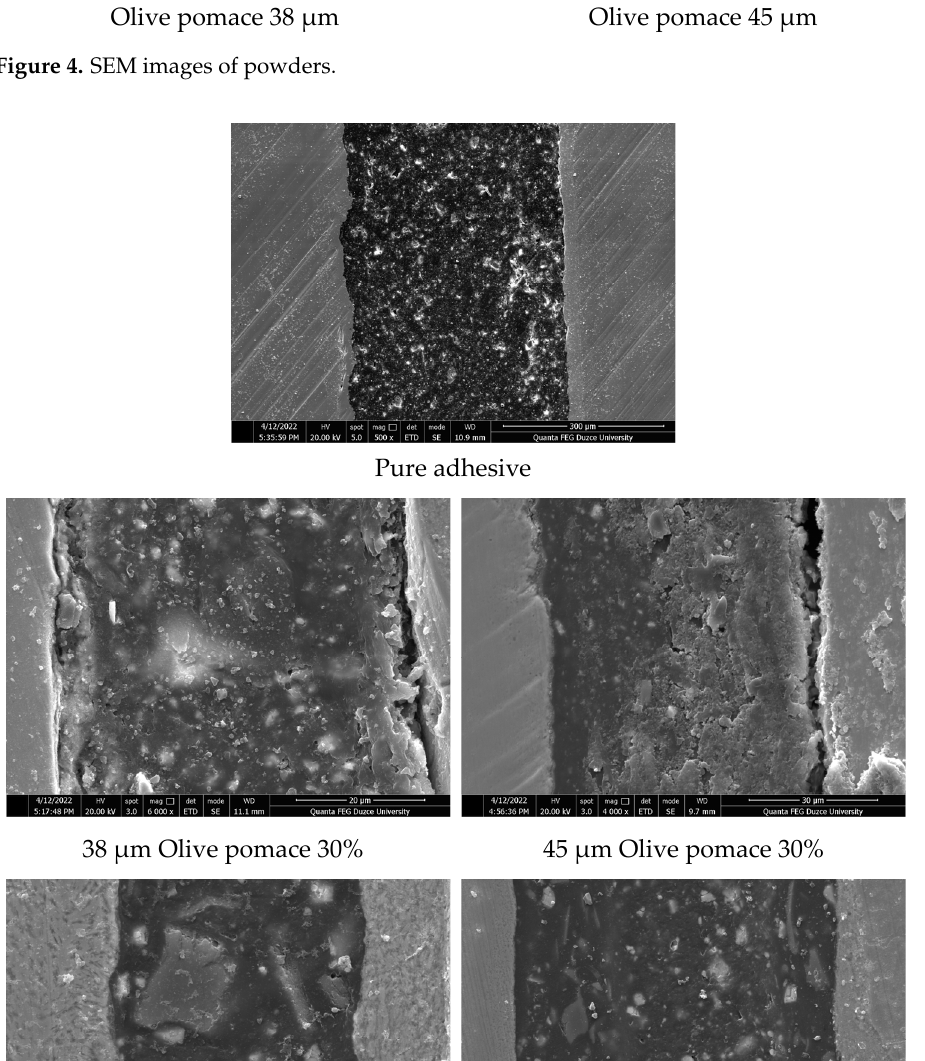
Figure 1. SEM images of powders.